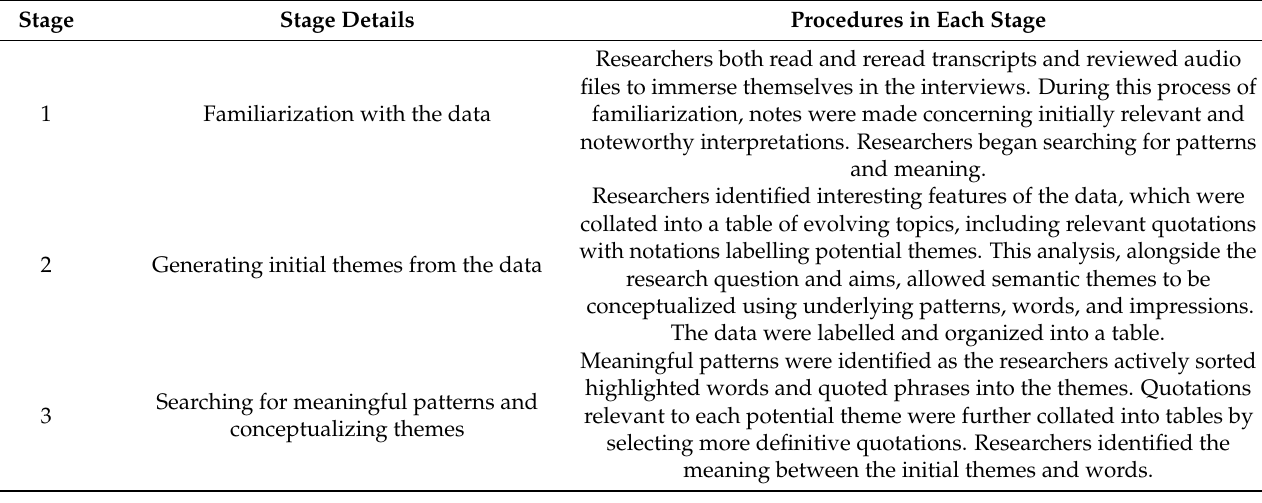
Table 1. Stages of Braun and Clarke’s reflexive thematic analysis [25] utilized to analyse the data collected from interviews with the